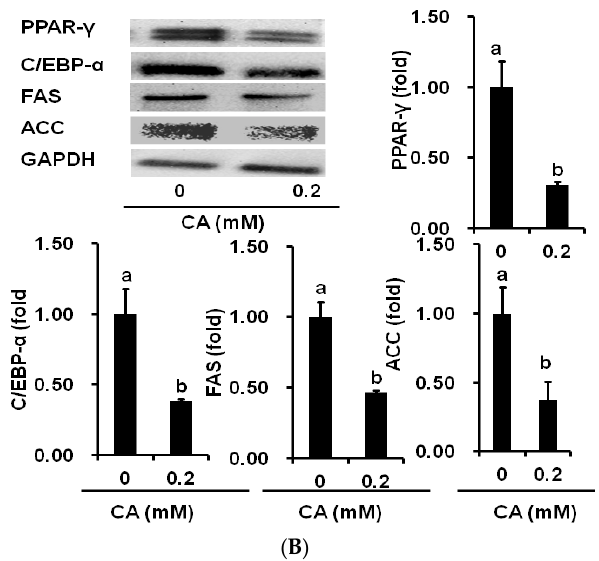
Figure 5. Effects of coumaric acid on peroxisome proliferator-activated receptor gamma-2 (PPAR- γ 2), CCAAT/enhancer binding protein-alpha (C/EBP- α ), sterol regulatory element binding protein-1 (SREBP-1), fatty acid synthase (FAS), acetyl CoA carboxylase (ACC). CA treatment downregulated the adipogenic and lipogenic mRNA expressions at differentiation periods. ( A ) quantification of mRNA expressions in experimental adipocytes using the qPCR technique. The results represent the mean ± SEM of six replicates. The different letters—a, b, c—within a treatment indicate significant differences ( p < 0.05); and ( B ) qualitative and quantitative analysis of protein expressions in experimental cells by Western blot and ImageJ software (1.49 version, 32 bit, Wayne Rasband, National Institute of Health, Bethesda, MD, USA). The results represent the mean ± SEM of three replicates. The different letters—a, b—within a treatment indicate significant differences ( p < 0.05).